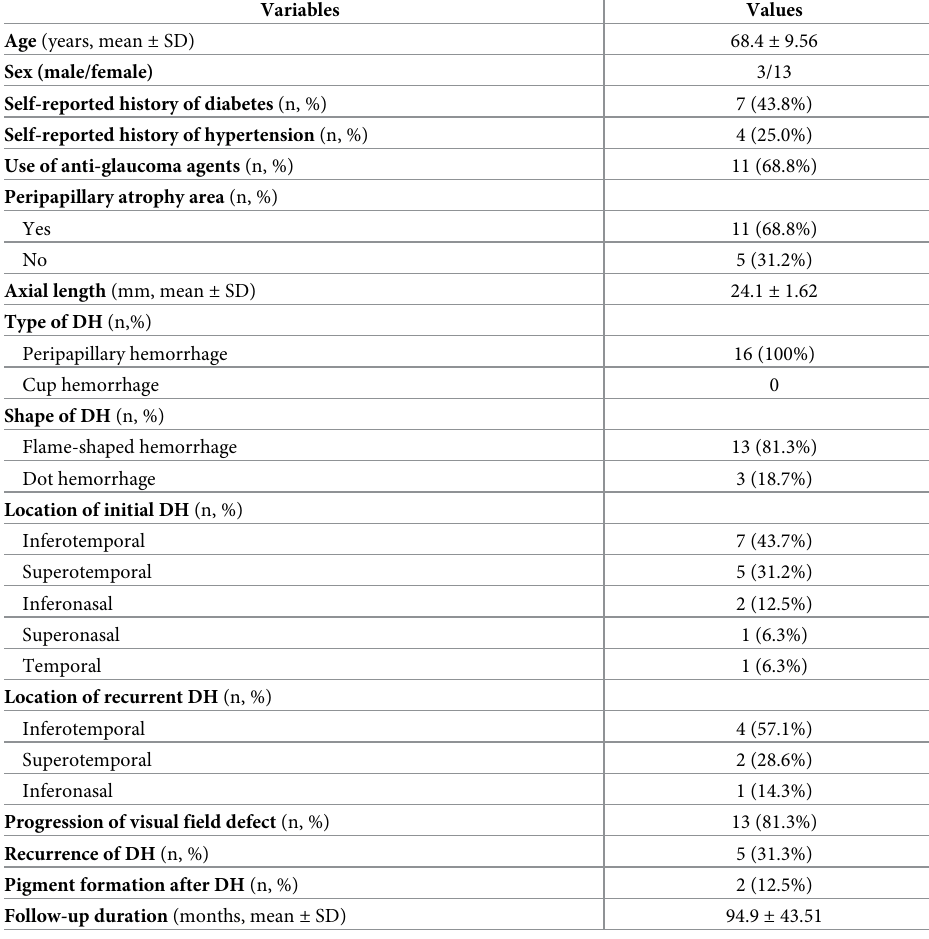
Table 1. Characteristics of nonglaucomatous patients with DH.